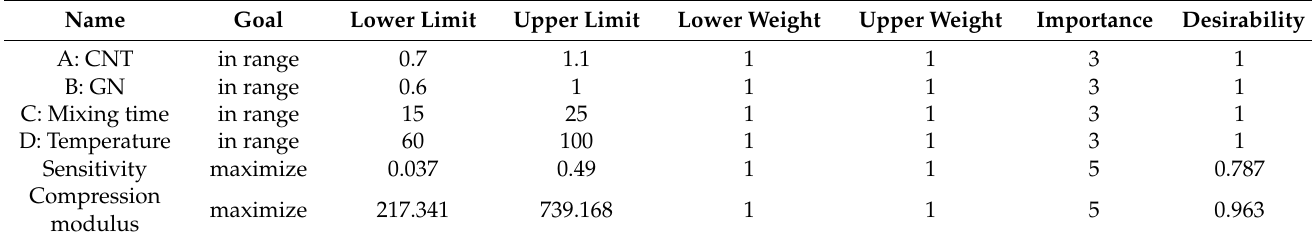
Table 5. Specification for factors and responses with weightage and importance.